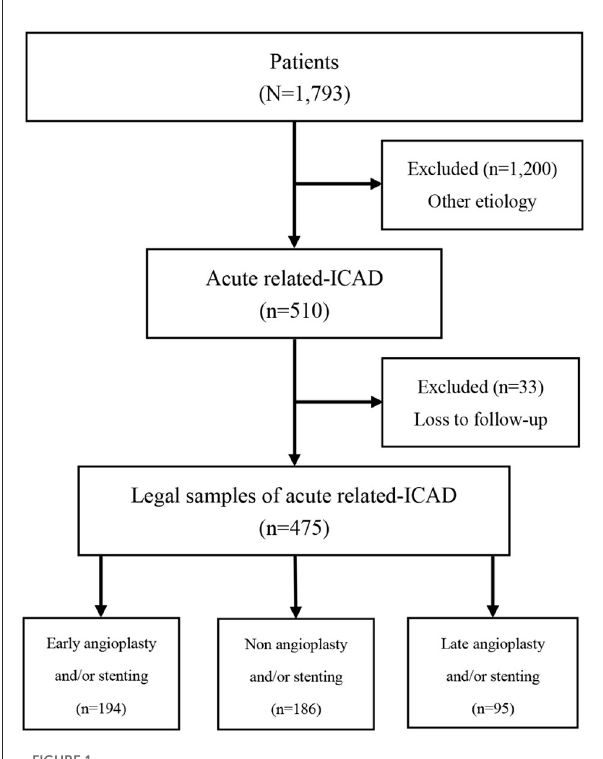
FIGURE1 Flow diagram of recruitment of patients with acute intracranial atherosclerotic disease-related large-vessel occlusion stroke.